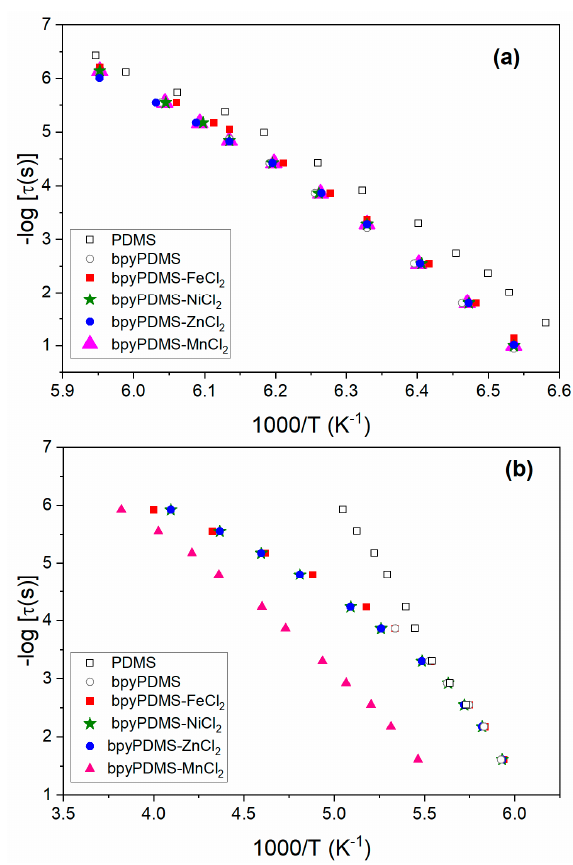
Figure 9. The activation maps for: ( a ) cooperative movements of amorphous chains, i.e., α relaxation, ( b ) cooperative motions in constrained phase, i.e., α ac relaxation for PDMS, bpyPDMS and metalloorganic complexes. The points were taken from the maxima of relaxation processes in ε ” representation (Figure 5).